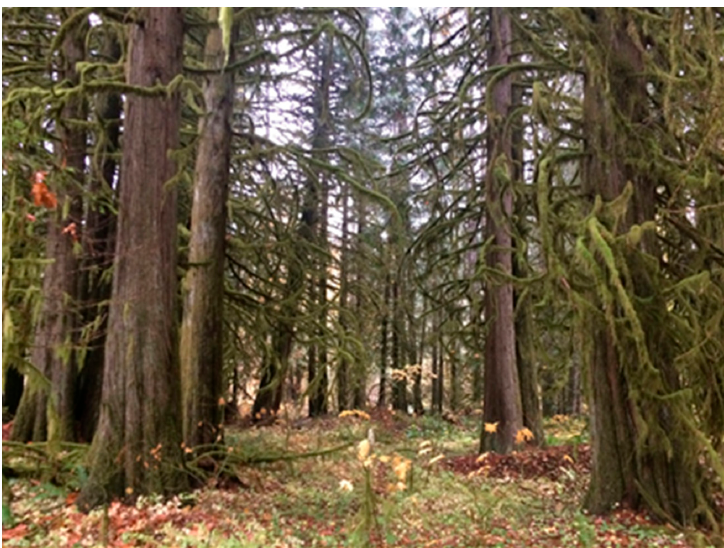
Figure 5. A mature Western Red cedar stand in the Oregon Coast range. The stand averaged 280 mtCO 2 e/acre.